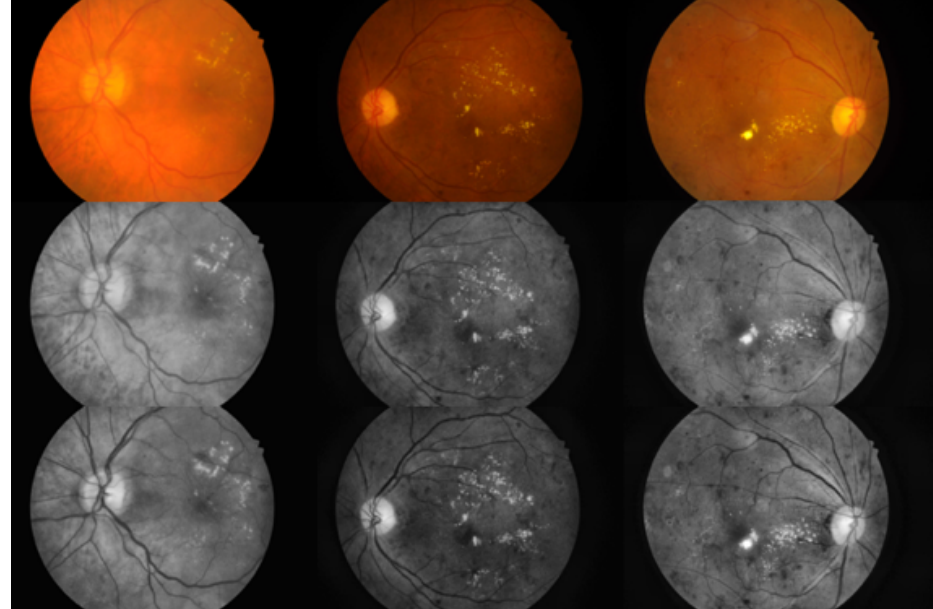
Figure 7. Comparison of our method with typical adaptive histogram equalization. From left to right, the images shown are ( top ) a bright image; ( middle ) a dark image; and ( bottom ) a normal image. It is clear that our method effectively improves the image contrast, which is helpful for MA